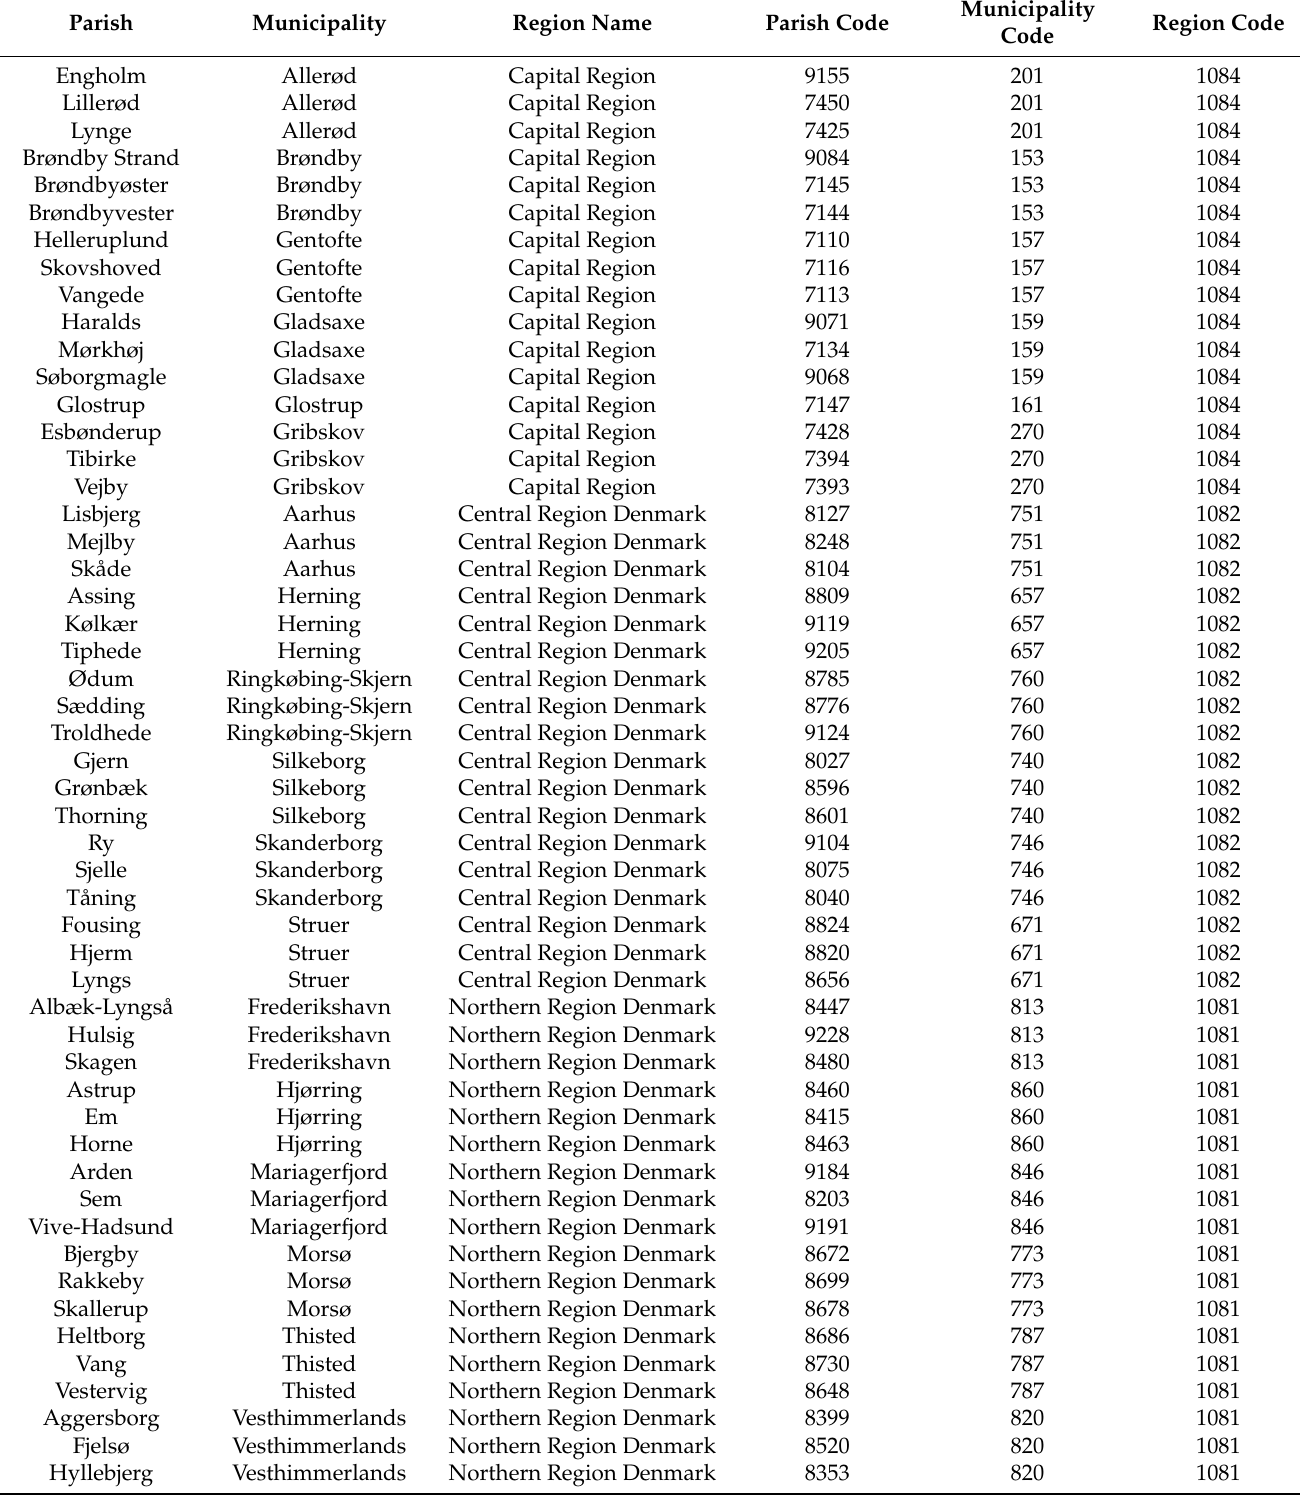
Table A1. List of the parishes in the five regions with 32 municipalities with 3 parishes randomly selected for this study (Glostrup only had one